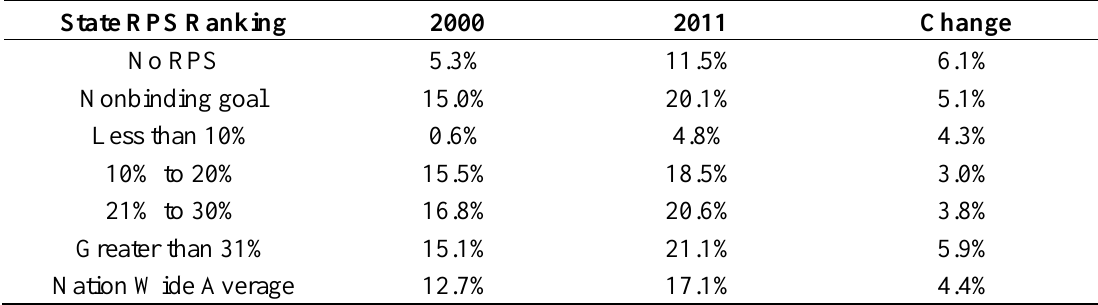
Table 5. Change in percent of total energy generation produced from renewable sources, 2000 to